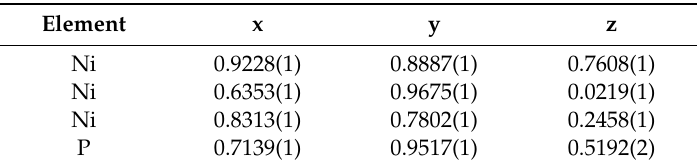
Table 1. Fractional atomic coordinates of Ni 3 P at ambient pressure and temperature (numbers in parentheses represent errors in the last digit) .